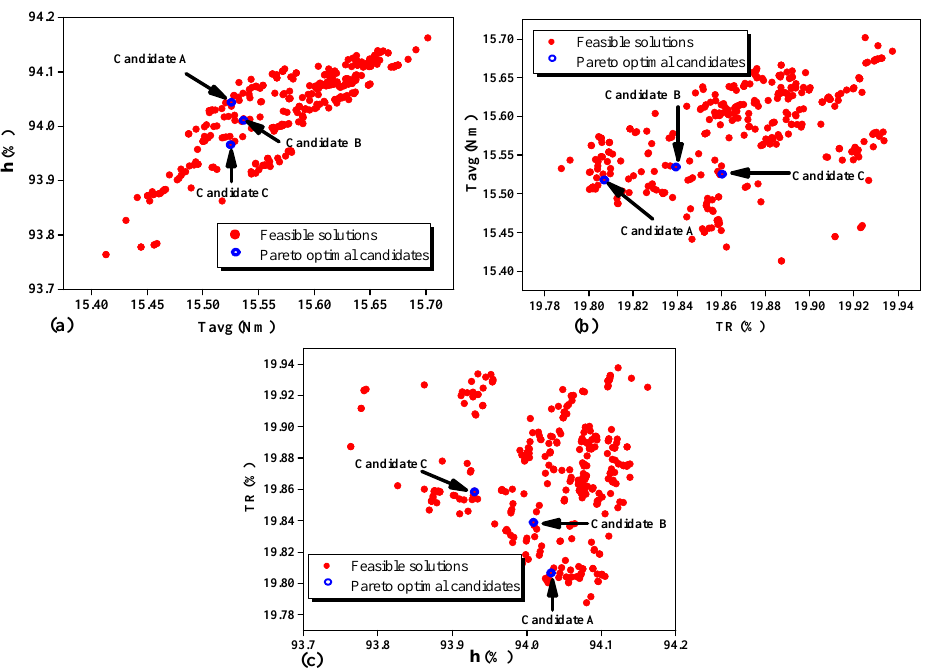
Figure 14. Pareto fronts of the multiobjective optimization obtained from the proposed GARS and NSGA-II-based method ( a ) Efficiency with Average Torque ( b ) Average Torque with Torque Ripple ( c ) Torque Ripple with Efficiency.